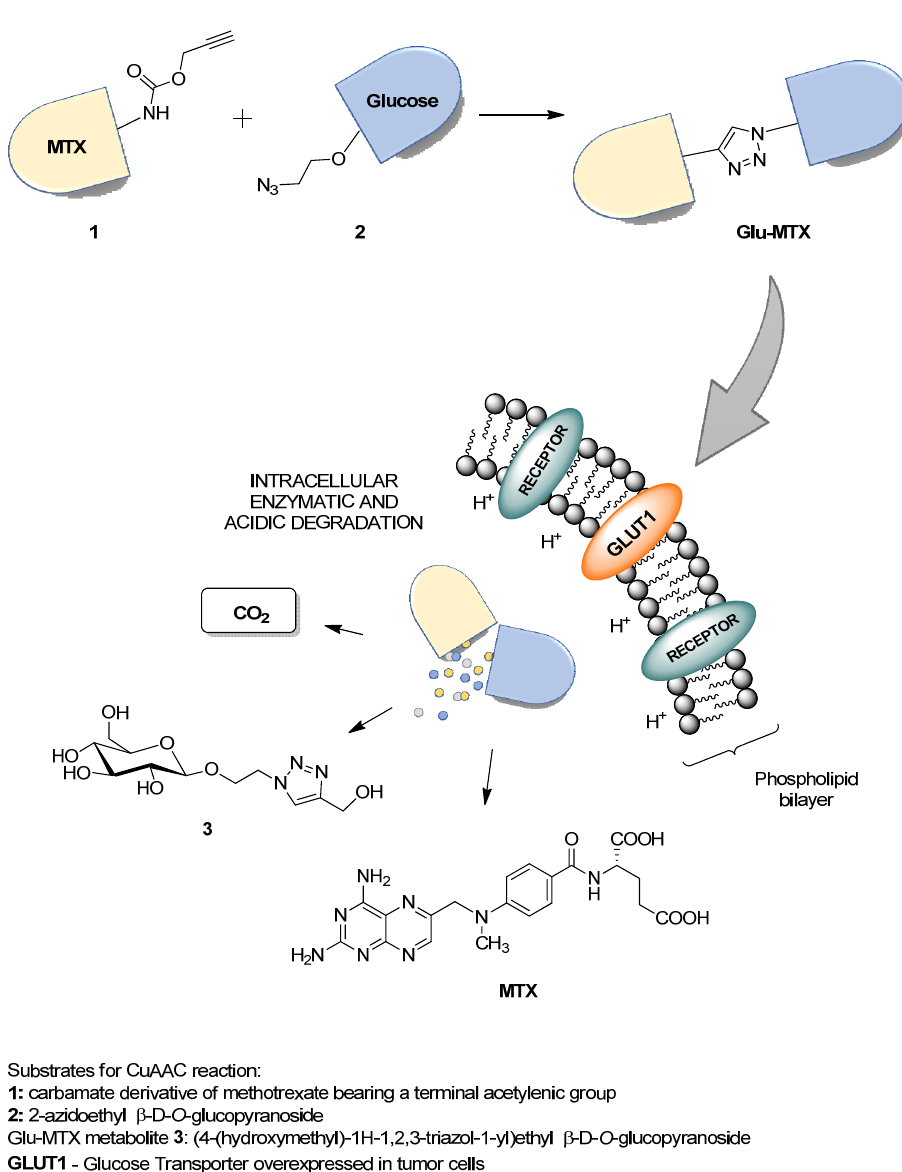
Figure 1. Scheme of Glu–MTX synthesis via copper-catalyzed 1,3-dipolar azide–alkyne cycloaddition (CuAAC), its transport into the cancer cell through the overexpressed GLUT1 transporters, and intracellular enzymatic and acidic degradation leading to the controlled release of biologically active metabolites (MTX and compound 3 ).